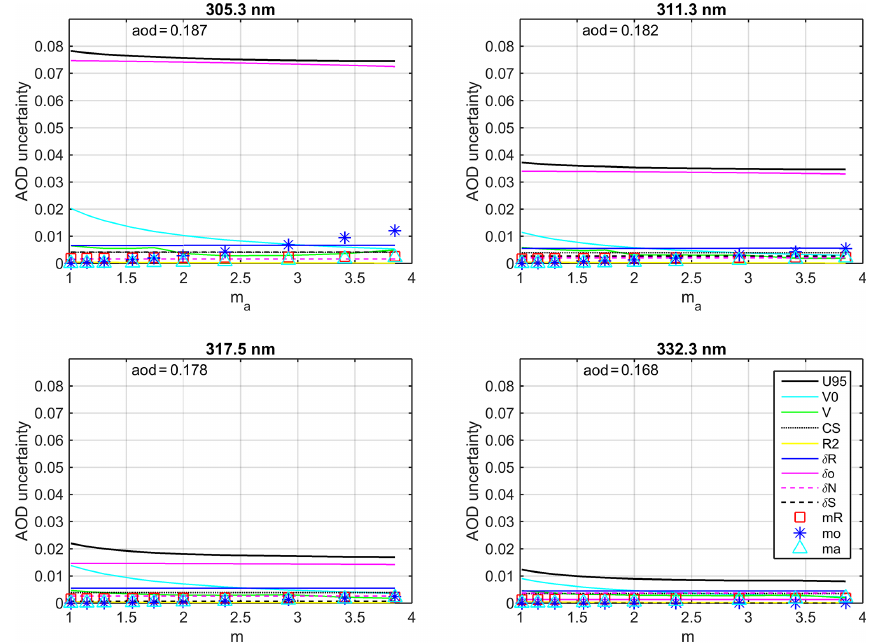
Figure 4. Estimated expanded uncertainty, k = 2 (black lines), of AOD for the UVPFR no. 1001 wavelengths. Individual contributing uncertainties sources, at an approximate level of confidence of 95%, are also shown. Calculations are made for a day 2 months after a calibration and with total column ozone amount of 350DU.